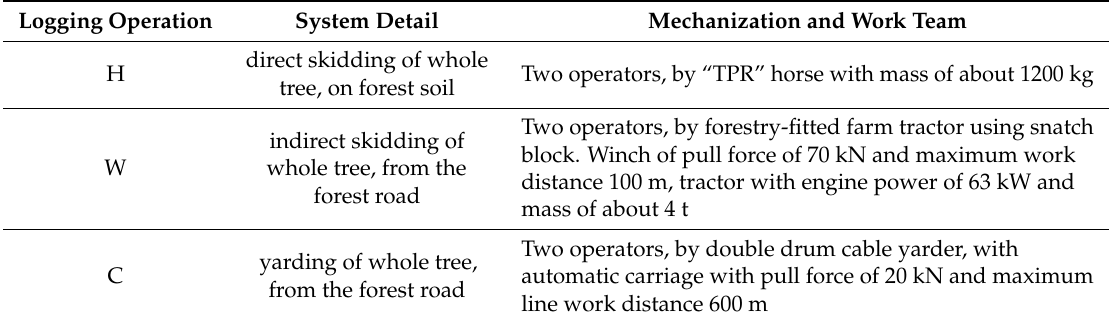
Table 2. Different extraction methods applied, characterized by different machines and techniques. Logging Operation